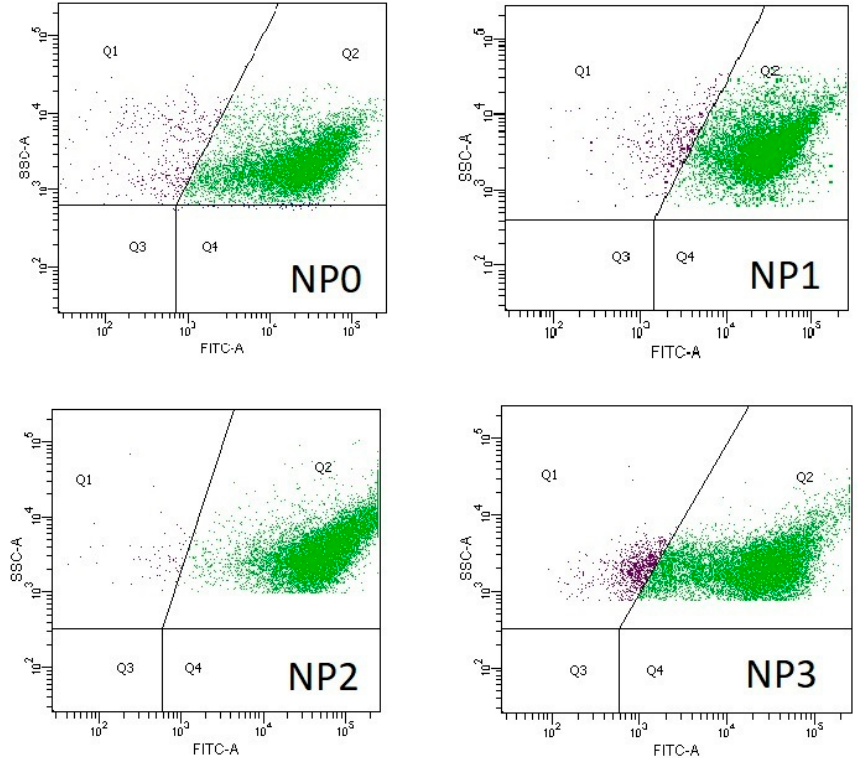
Figure 2. Cytometric analysis of microbial metabolic activity in experimental variants after 24 h of biodegradation. The metabolically active population (Q2) is marked in green, the metabolically inactive population (Q1) is marked in purple.